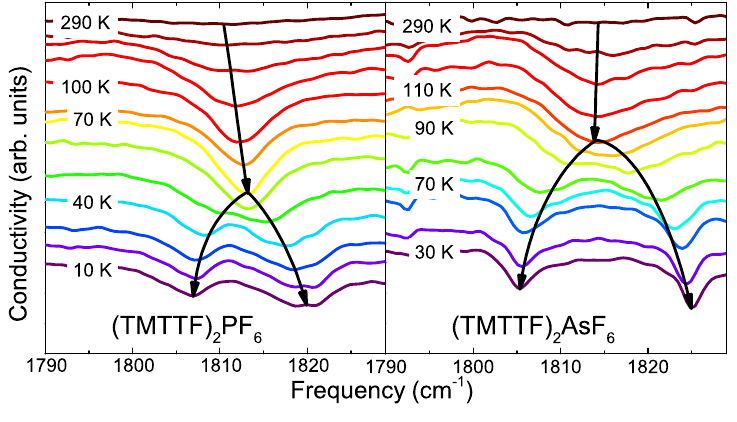
Figure 21. Mid-infrared conductivity σ polarized parallel to the molecular stacks ( E (cid:107) a ) in the vicinity of the emv-coupled totally symmetric intramolecular ν are displaced by a constant factor to avoid overlap. The arrows indicate the positions of the antiresonance dips. In the case of (TMTTF) clear